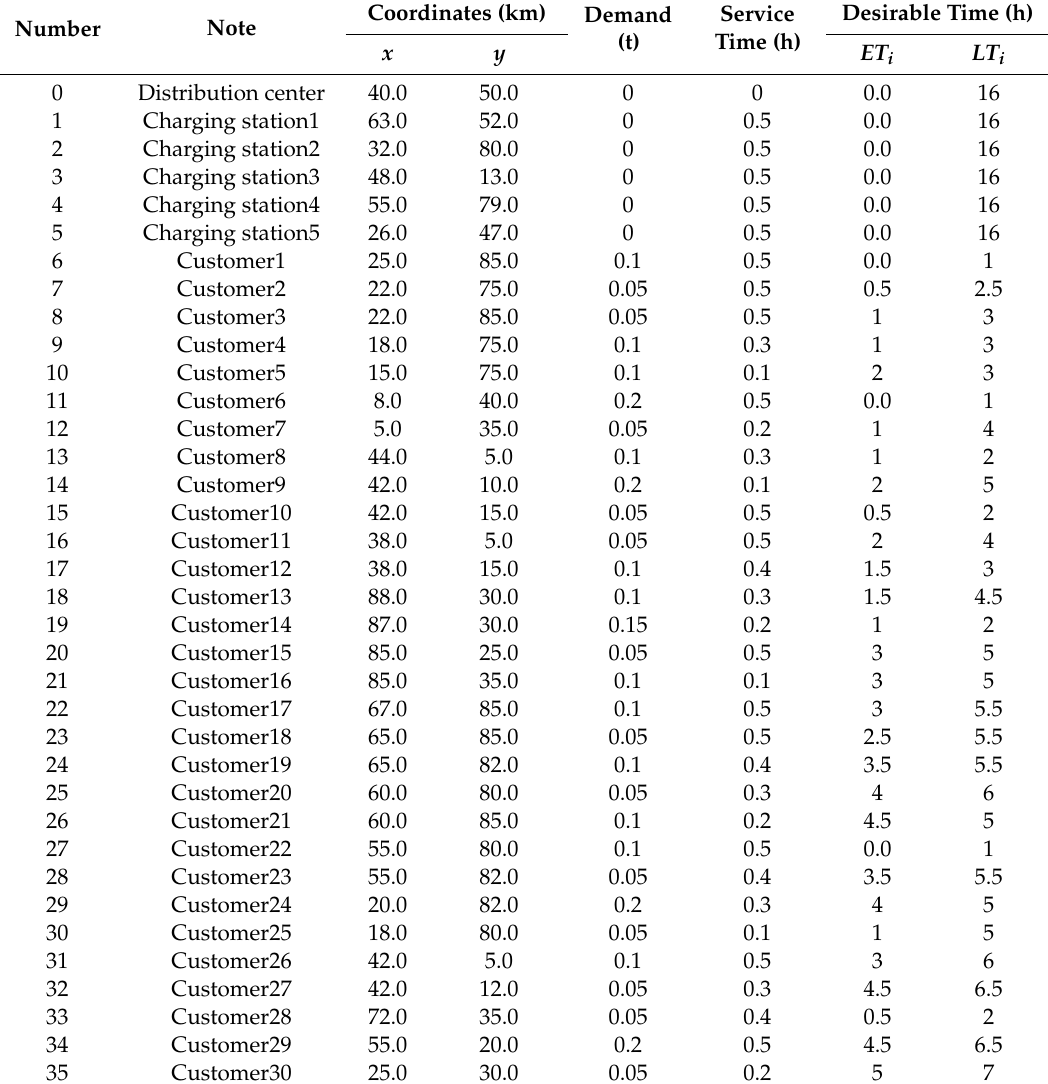
Table 3. Information of the selected example.